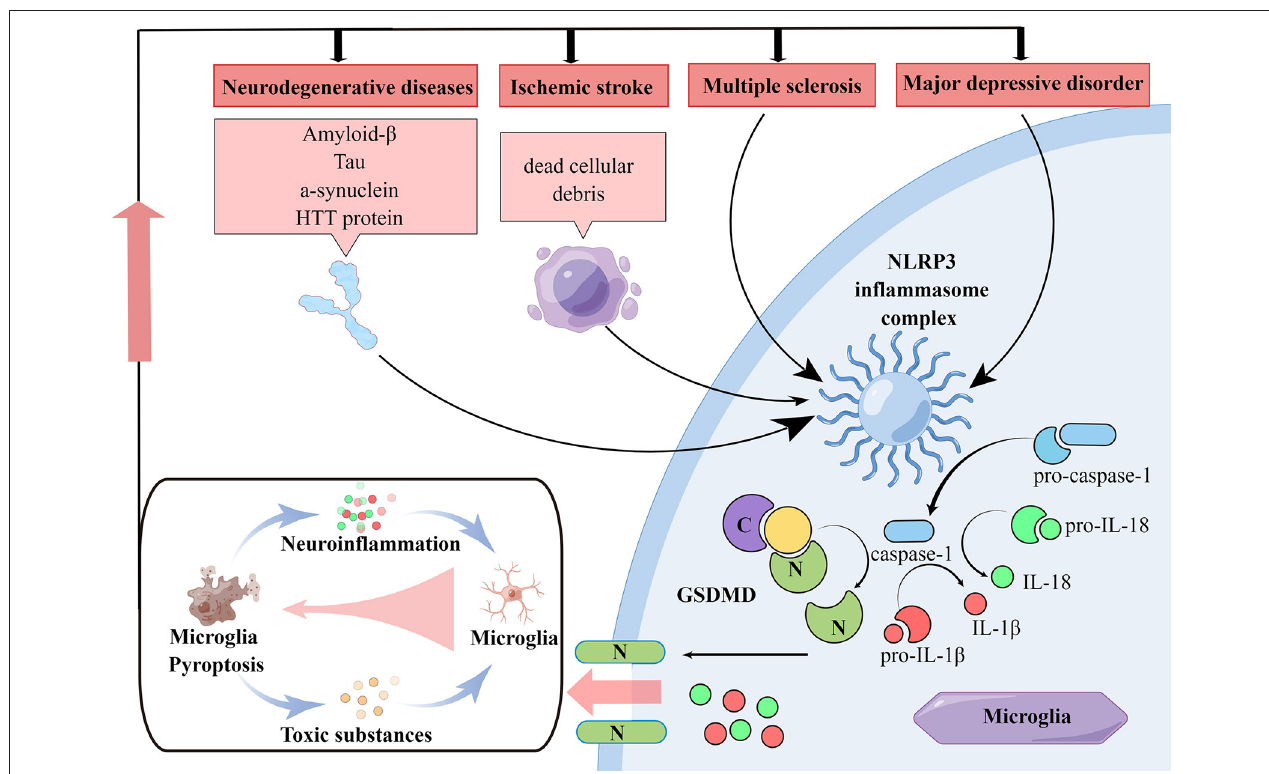
FIGURE 1 | Pathologies of neurological diseases associated with microglia pyroptosis. In various neurological diseases, NLRP3 inflammasome in microglia can be activated and then the caspase-1 is activated. Activated caspase-1 on the one hand cleaves GSDMD, which produces N-terminal structural domain and induces cell membrane perforation and subsequent pyroptosis. On the other hand, activated caspase-1 cleaves IL-1 β and IL-18 precursors, rising the extracellular level of IL-1 β and IL-18 and amplify neuroinflammatory responses. In neurodegenerative diseases, various misfolded aggregated proteins are taken up by microglia, leading to NLRP3 inflammasome activation and microglia pyroptosis. While in ischemia stroke, ischemic necrotic cell debris is taken up by microglia performing immune clearance functions, leading to microglia NLRP3 inflammasome activation. Microglia NLRP3 inflammasome activation is also present in MDD and MS. All these diseases lead to NLRP3-dependent microglia pyroptosis and neuroinflammation. Moreover, worsening neuroinflammation promotes the production of multiple pathological markers of neurological disease and induces microglia pyroptosis, which leads to persistent disease